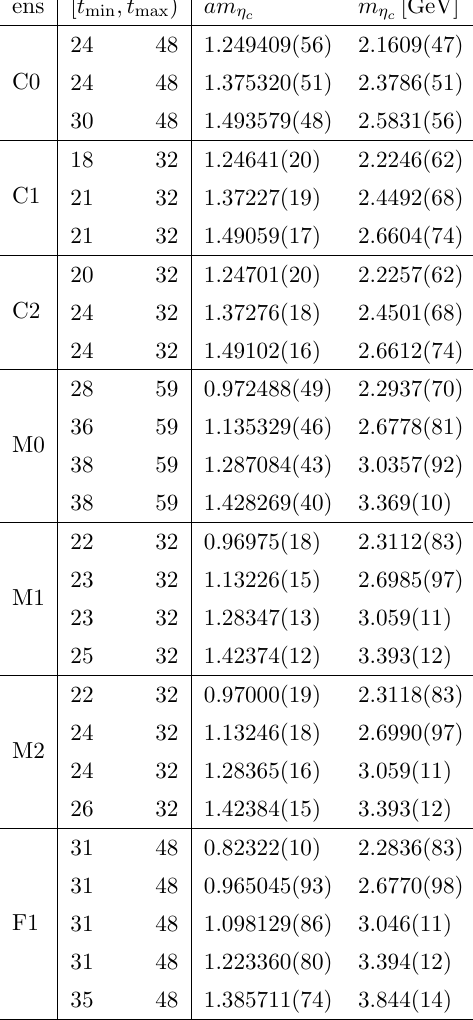
Table 13 . Fit results for the masses of the connected part of the (cid:17) c meson on all